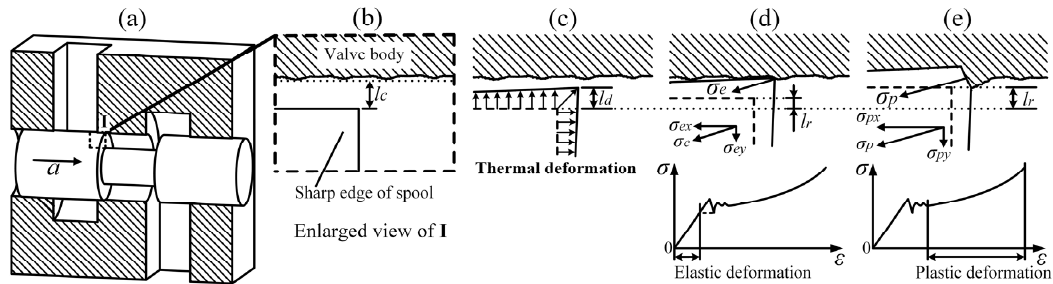
Figure 1. Micro-mechanism of spool clamping caused by thermal deformation of the valve orifice: ( a ) The standard structure of a spool valve; ( b ) Enlarged micron-level view of valve orifice; ( c ) Radial thermal deformation l d ; ( d ) Spool clamping caused by small radial fretting allowance l r ; ( e ) Spool clamping caused by large radial fretting allowance l r .